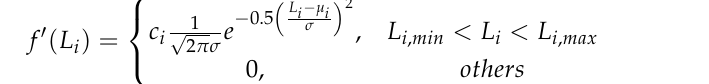
Figure 2. Random label sample ranges distributed along the length of quantization step ∆ = 1. The mean and variance of truncated normal distribution based on r L | r Li | L i , max + L i , min and σ = , respectively. To eliminate the probabilities of the same la- 2 2 bels, the random label value distribution range of agent i is modified to an open interval ( L ) . Thus, the probability density function of the corresponding label value is i ,min , L i ,max given